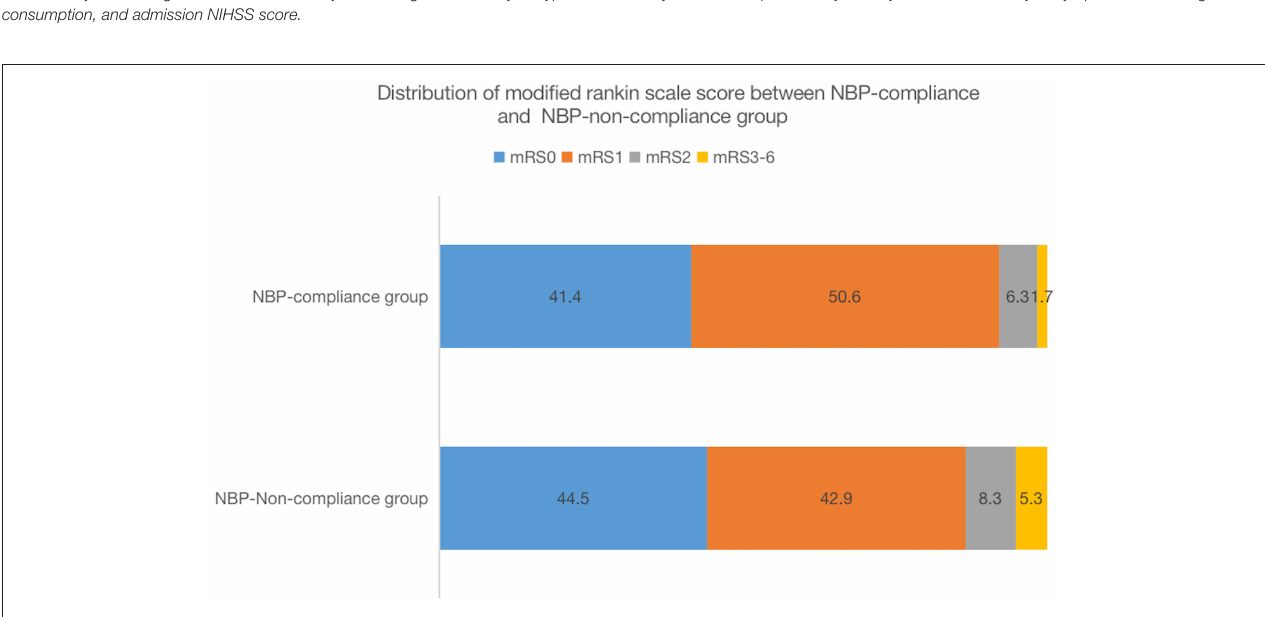
FIGURE 2 | Distribution of modified rankin scale score between NBP-compliance and NBP-non-compliance